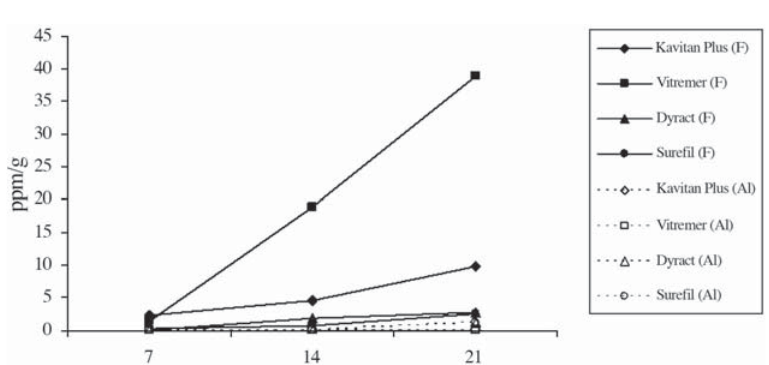
Figure 3- (cid:4)(cid:31)(cid:27)(cid:17)(cid:27)(cid:6)(cid:7)(cid:12)(cid:9)!(cid:14)(cid:4)"(cid:27)(cid:18)(cid:24)(cid:9)(cid:16)(cid:14)(cid:4)(cid:7)(cid:10)(cid:16)(cid:4)(cid:7)(cid:6)(cid:27)(cid:17)(cid:9)(cid:10)(cid:27)(cid:17)(cid:4)(cid:24)(cid:14)(cid:6)(cid:14)(cid:7)(cid:21)(cid:14)(cid:16)(cid:4)(cid:29)(cid:24)(cid:18)(cid:17)(cid:4)(cid:14)(cid:7)(cid:8)(cid:13)(cid:4)(cid:17)(cid:7)(cid:12)(cid:14)(cid:24)(cid:9)(cid:7)(cid:6)(cid:4)(cid:9)(cid:10)(cid:4)(cid:16)(cid:18)(cid:27)(cid:2)(cid:6)(cid:14)(cid:4)(cid:16)(cid:9)(cid:21)(cid:12)(cid:9)(cid:6)(cid:6)(cid:14)(cid:16)(cid:4)(cid:19)(cid:7)(cid:12)(cid:14)(cid:24)(cid:4)(cid:7)(cid:29)(cid:12)(cid:14)(cid:24)(cid:4)(cid:16)(cid:7)(cid:3)(cid:4)(cid:30)